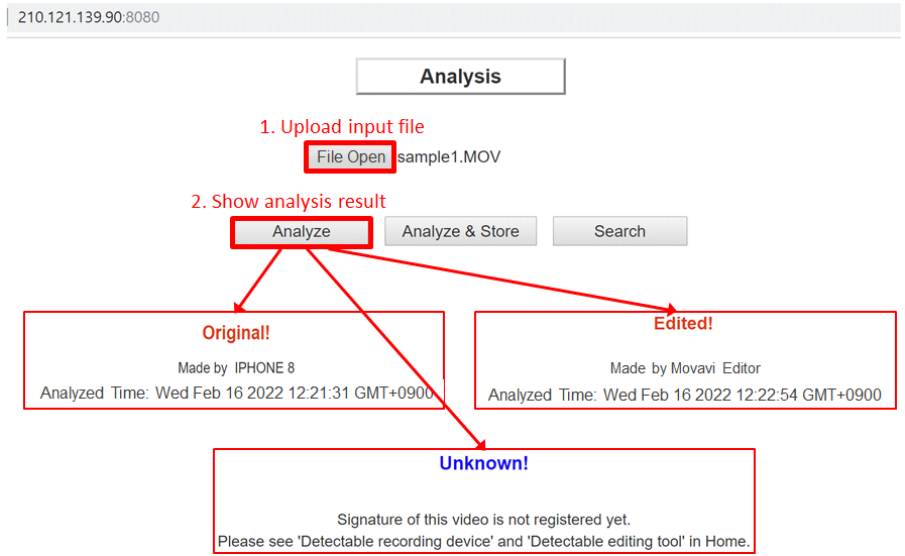
Figure 7. Graphic User Interface for the integrity analysis